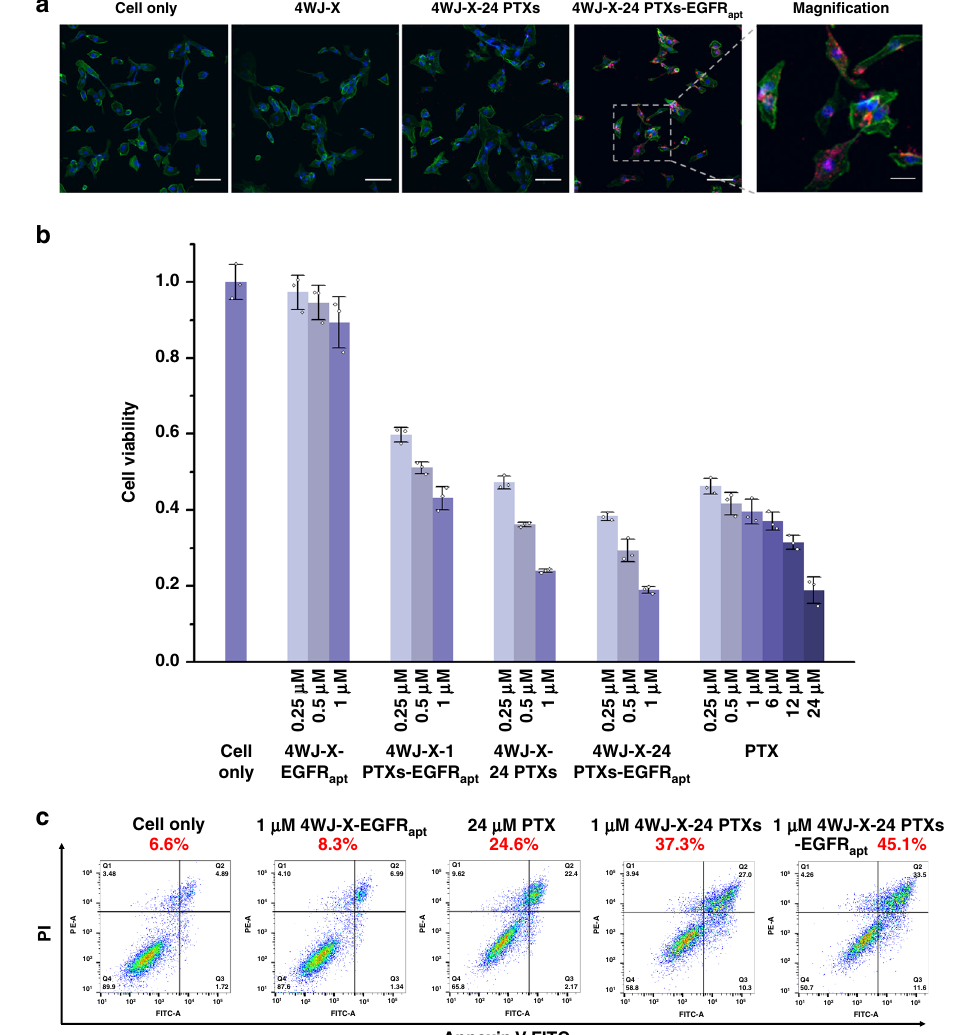
Fig. 5 In vitro cell binding, cytotoxicity and apoptotic effects of 4WJ-X-24 PTXs nanoparticles. a In vitro cell binding of 4WJ-X-24 PTXs-EGFR apt nanoparticles, shown by confocal microscopy (blue: nucleus; green: cytoskeleton; red: RNA nanoparticles. Scale bar: 100 μ m for original images, and 20 μ m for magni fi ed image). b In vitro cytotoxicity study of 4WJ-X-24 PTXs-EGFR apt nanoparticles by MTT assay ( n = 3 independent samples, mean ± SD). c In vitro apoptosis effect of 4WJ-X-24 PTXs-EGFR apt nanoparticles by propidium iodide (PI)/Annexin V-FITC dual staining and fl uorescence-activated cell sorting (FACS) analysis (Q2 = Annexin V-FITC and PI positive, indicating cells in late apoptosis or already dead; Q3 = PI negative & Annexin V-FITC positive, indicating early apoptotic cells). Source data are provided as a Source Data fi